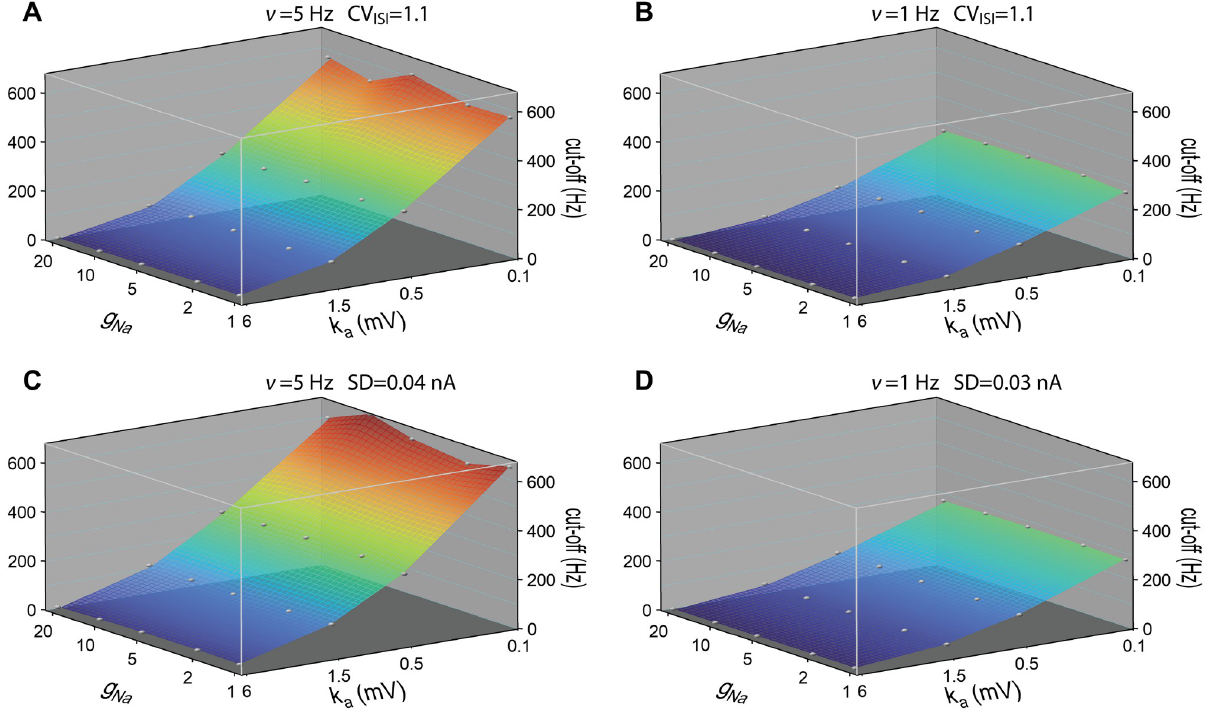
Fig 9. Cutoff frequencies of dynamic gain curves as a function of sodium peak conductance and voltage sensitivity of sodium activation curve. A and B For each pair of voltage sensitivity and sodium peak conductance, the dynamic gain curve was calculated at 5Hz and 1Hz firing rates working points. CV values were fixed at 1.1 ± 0.05. C and D The dynamic gain curves were calculated at 5Hz and 1Hz firing rate with std of stimuli fixed at 0.04nA and 0.03nA. Correlation time of background current was 50ms. x Na fixed at 40 μ m. Sodium peak conductance ranged from 1� g ranged from 0.1 to 6mV. Conductance and sensitivity are represented on a logarithmic scale. Grey points represent calculated data, continuous surfaces are obtained by Voronoi interpolation to allow for a continuous color representation.